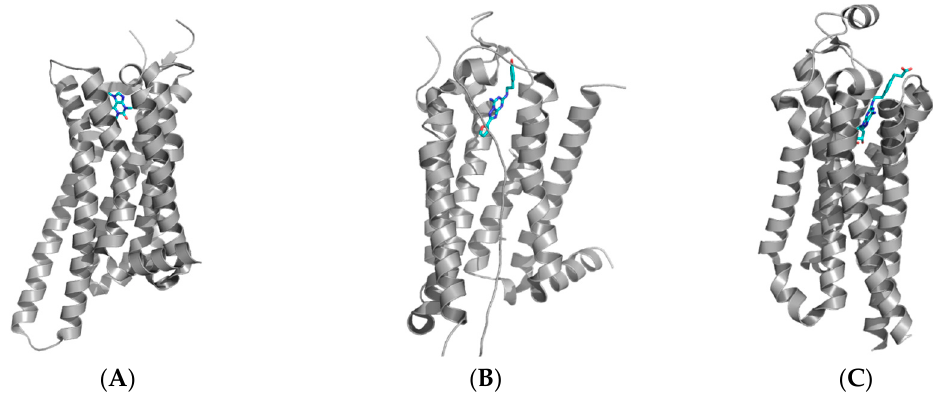
Figure 2. Structures of the adenosine A 2A receptor with ( A ) caffeine (PDB: 3RFM); ( B ) the antagonist ZM241385 (PDB: 3EML); and ( C ) the agonist CGS21680 (PDB: 4UG2). It has been shown that the extracellular loops play an important role in the agonist/antagonist interaction of compounds with the receptors. These crystal structures have been used to design novel small organic compounds which can be used to target the adenosine receptors.